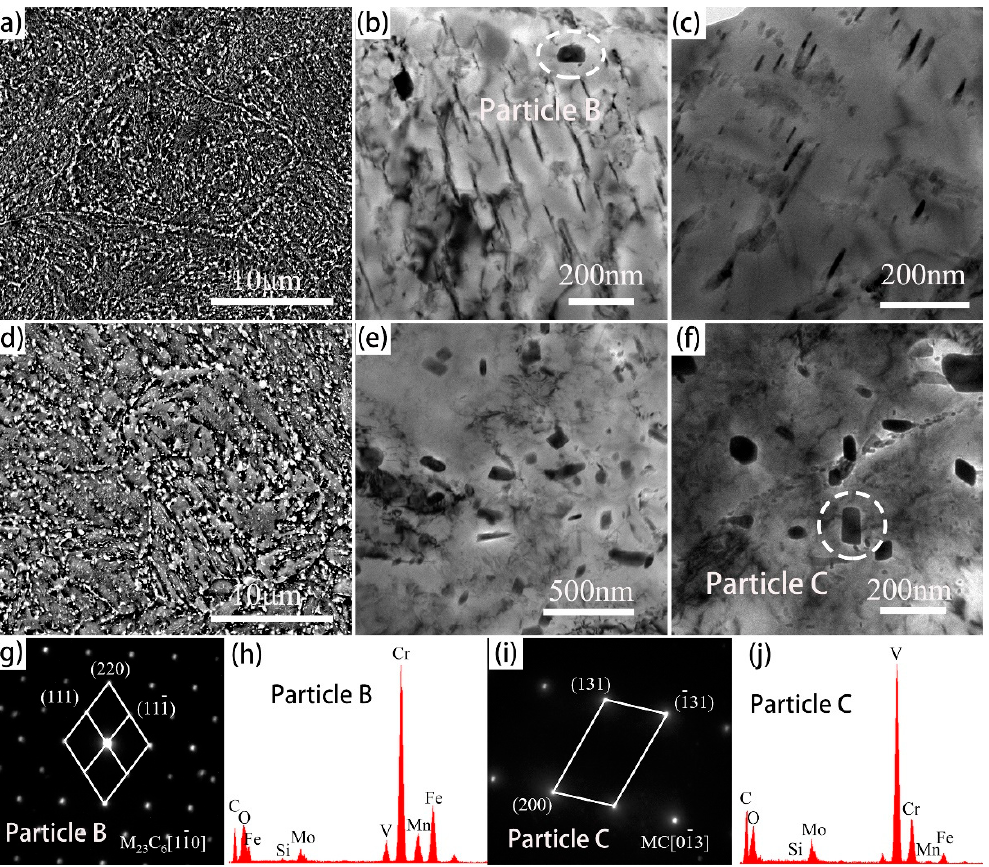
Figure 9. Microstructure of both steel alloys after tempering for 60 h: ( a ) microstructure of the 5Cr5Mo2 steel observed by SEM; ( b ) elliptical-shaped secondary carbides and ( c ) bar-like secondary carbides in the 5Cr5Mo2 steel observed by TEM; ( d ) microstructure of the H13 steel observed by SEM; ( e ) large-size and ( f ) fine secondary carbides in the H13 steel observed by TEM; ( g ) di ff raction and ( h ) energy spectra of particle B; ( i ) di ff raction and ( j ) energy spectra of particle C.